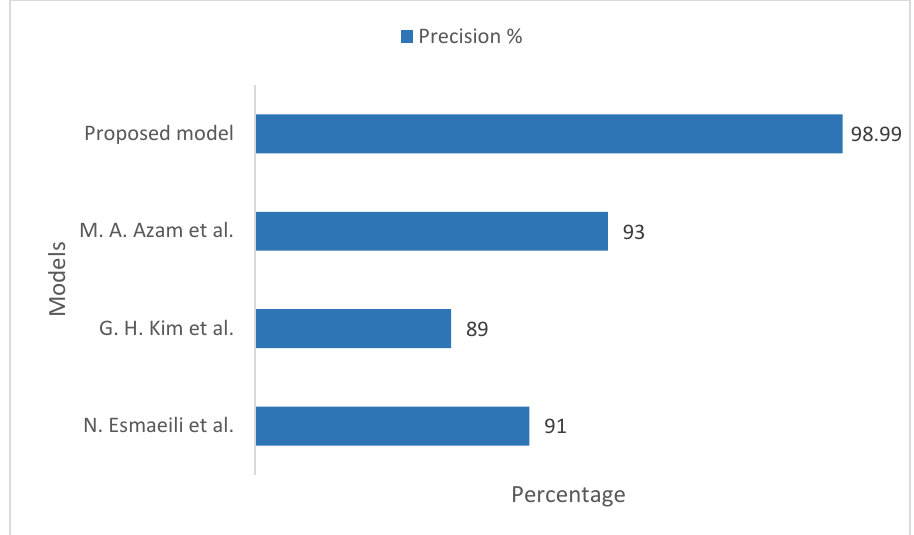
Figure 10. Comparison of precision between the proposed model and existing models, taking into account the ImageNet datasets [33–35].